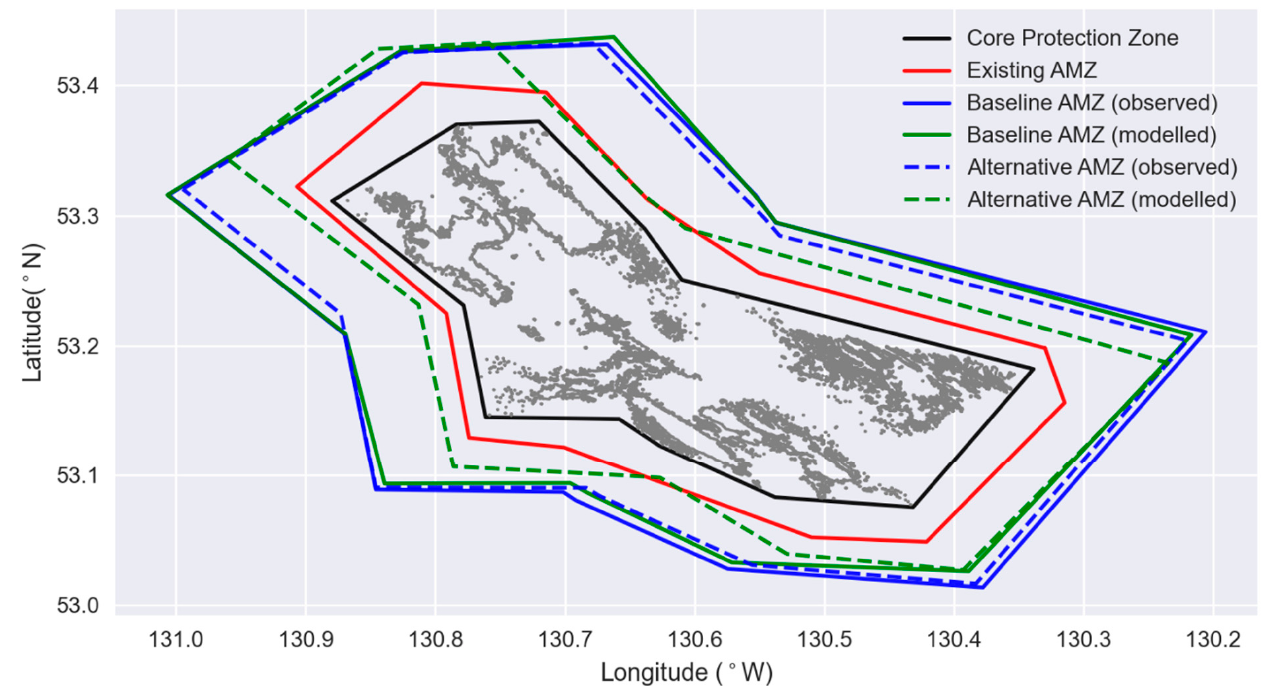
Figure 10. Map of the northern reef, CPZ, existing AMZ, and baseline AMZs using observed and modelled currents, as well as alternative AMZs using the observed and modelled currents.